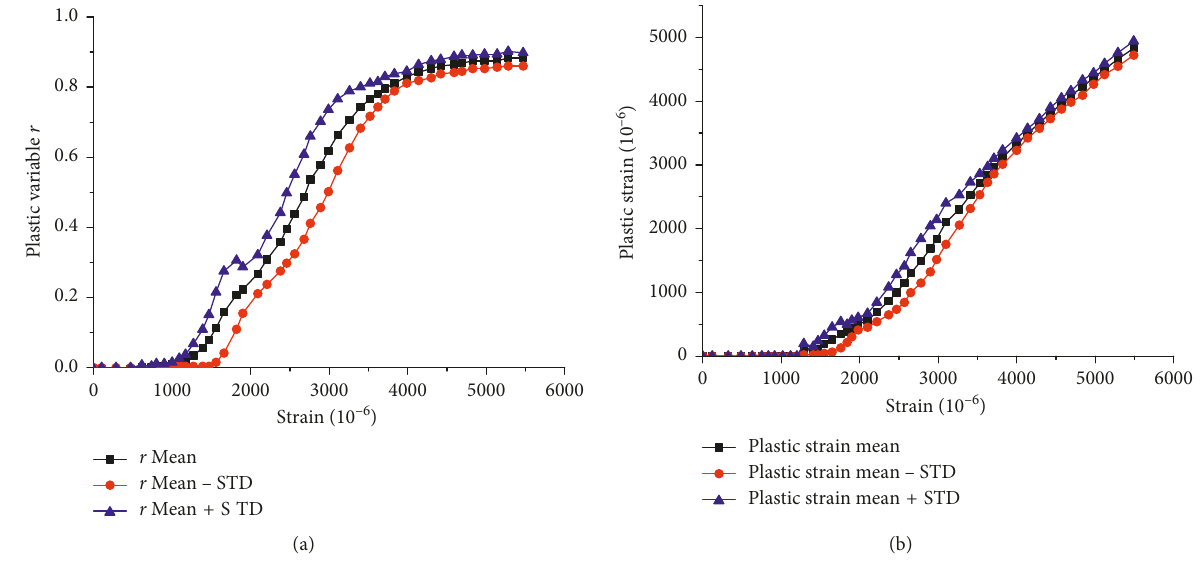
Figure 9: SE of plastic variable and plastic strains of SCC under compression obtained by the proposed model. (a) SE of plastic variable r . (b) Stochastic development of plastic